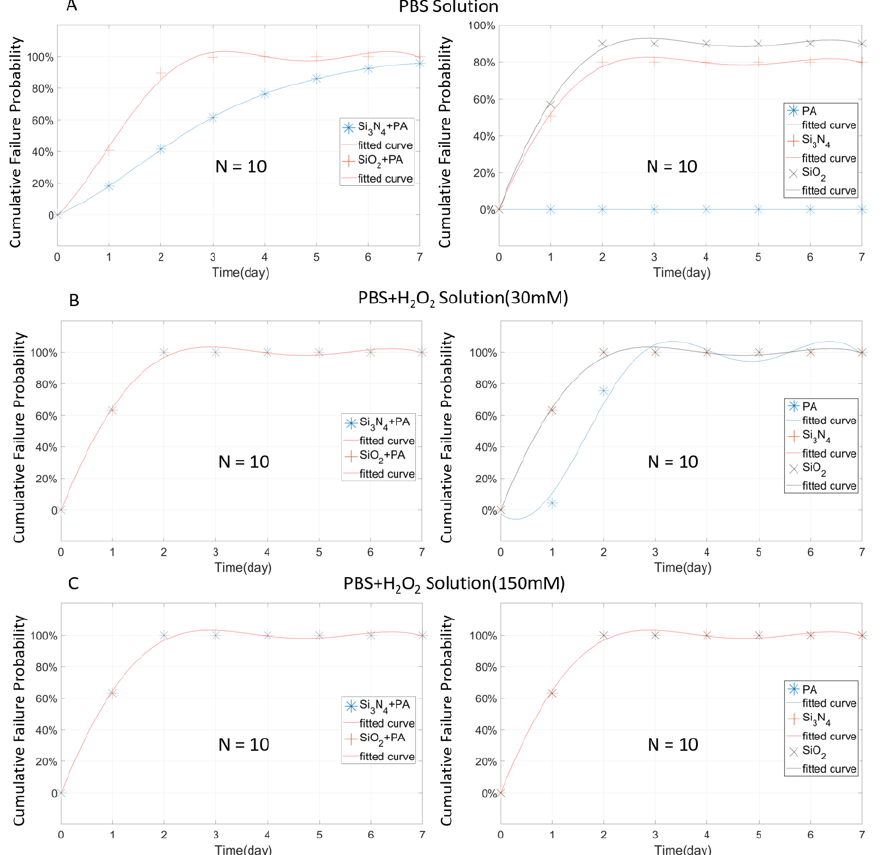
Figure 11. The Weibull cumulative distribution data and corresponding curve fitting of the open-tip tungsten wires coated with combined films of Si 3 N 4 (100 nm)/PA(1 µm) and SiO 2 (100 nm)/PA(1 µm)( left side ) versus the Weibull cumulative distribution data and corresponding curve fitting of open-tip wires with a single layer coating (1 µm) of PA, Si 3 N 4 and SiO 2 ( right side ), tested at 67 °C in different solutions.